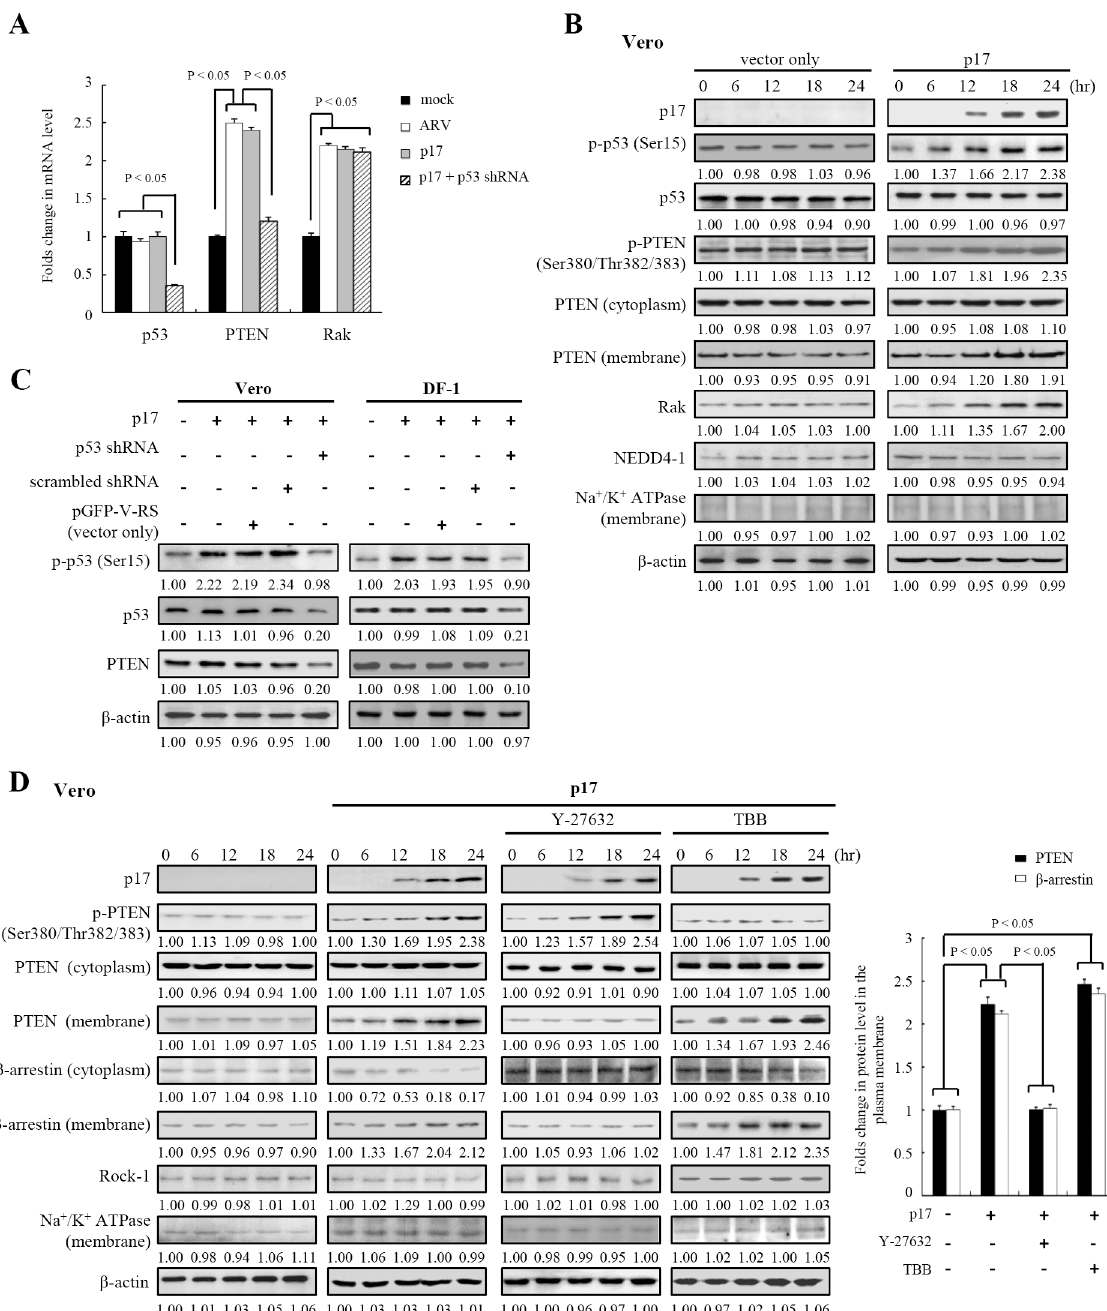
PLOS ONE | DOI:10.1371/journal.pone.0133699 August 5,